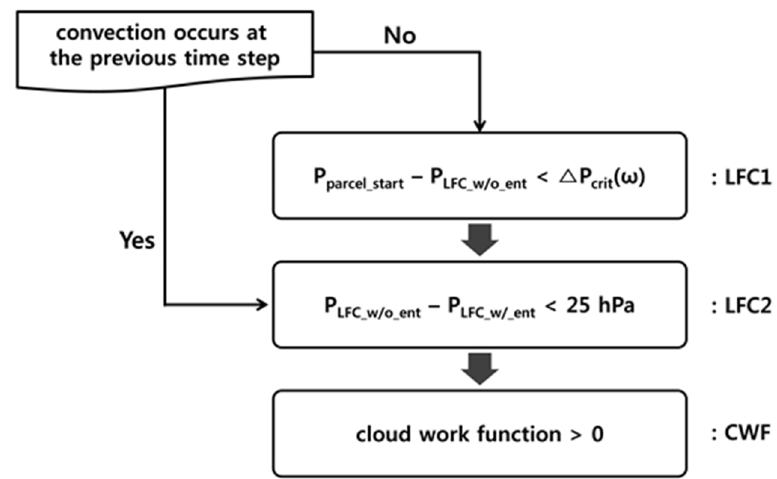
Figure 6. Schematic diagram of the modified triggering process in the simplified Arakawa-Schubert (SAS) convection scheme.